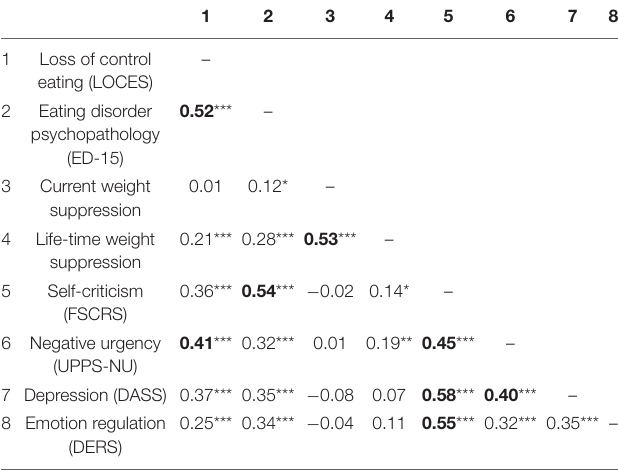
TABLE 1 | Correlation between variables under